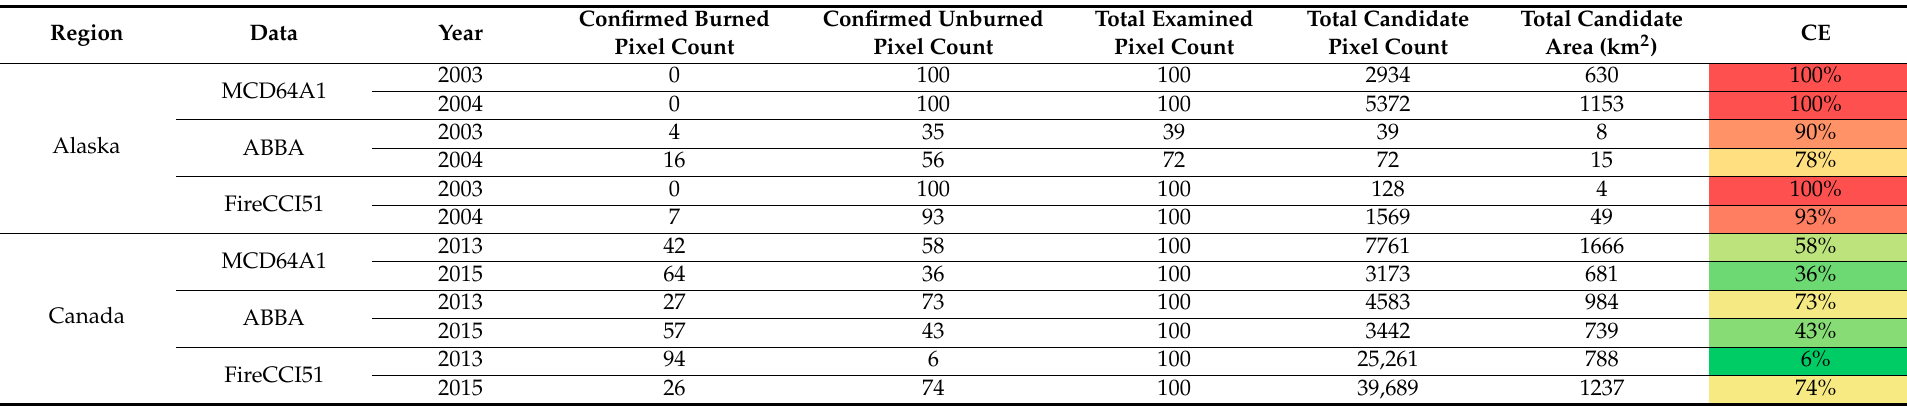
Table 5. Results of the visual examination on sample points selected based on the burned pixels located outside the buffer zones as mapped by three burned area products. The cells that contain CE values are colored, with green to red indicating low to high CE